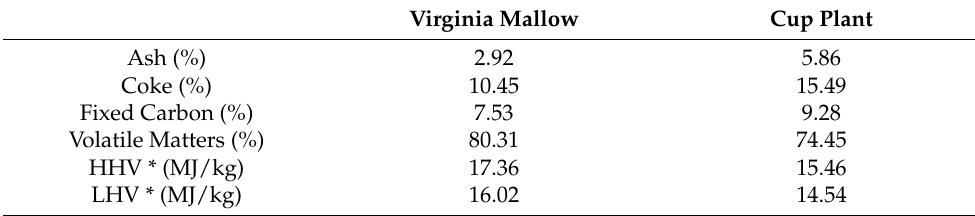
Figure 2. Climate diagram with data from the meteorological station ‘Maksimir’ for the period of June (6) to September (9) (Croatian Meteorological and Hydrological Service, 2022). Table 1. Proximate analysis of Virginia mallow and cup plant biomasses. Table 1. Proximate analysis of Virginia mallow and cup plant